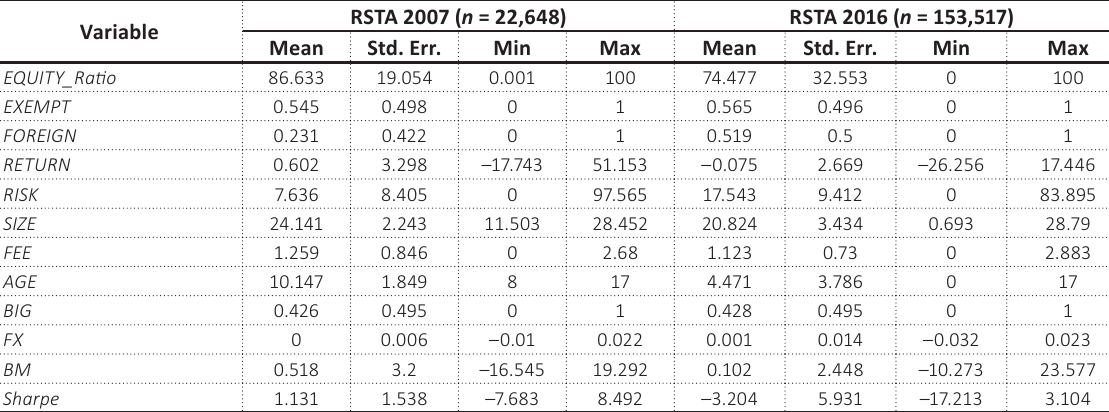
Table 4. Descriptive statistics of major variables for RSTA 2007 and